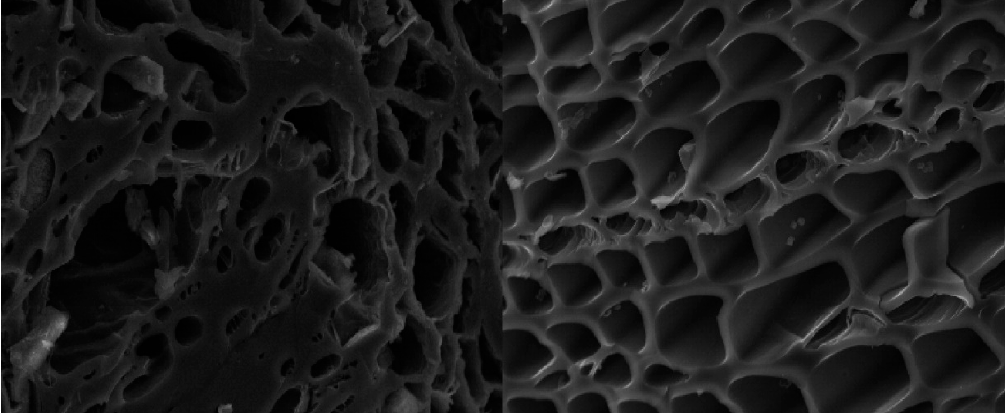
Figure 1. The porous structure of biochar [35].